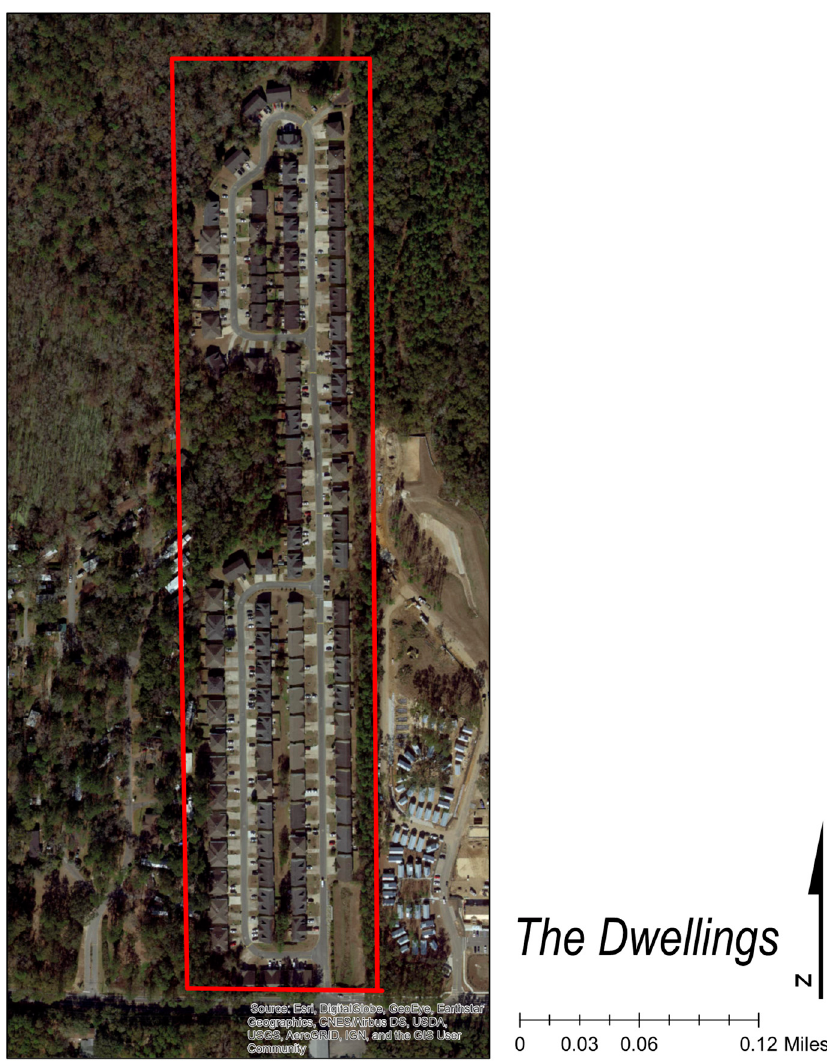
Figure 3. Dwellings Community Plan (Aerial).